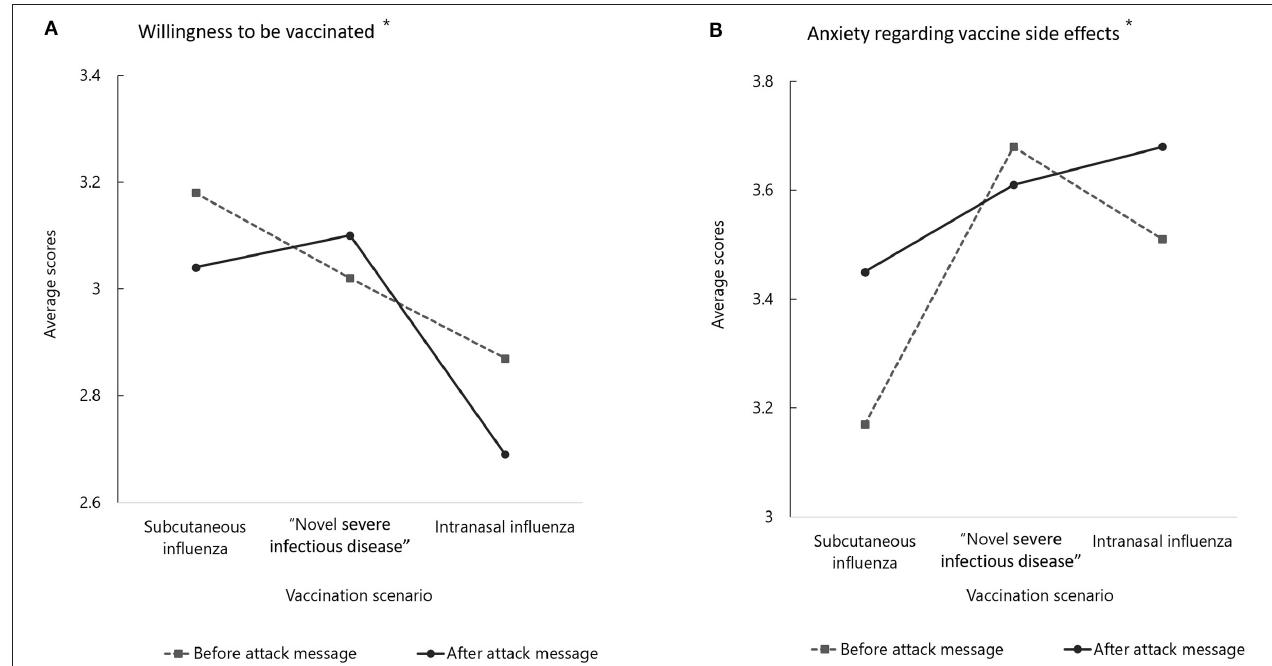
FIGURE 1 | Evaluation of vaccination intention and anxiety regarding vaccine side effects between before and after the attack message among vaccination scenarios. *A significant interaction between the impact of the attack message and the vaccine scenarios was obtained ( p < 0.01). “Novel severe infectious disease” is the scenario of the fictitious